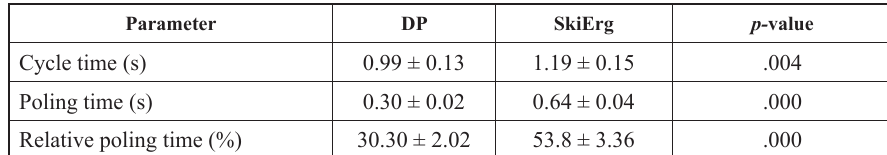
Table 2. Average duration of muscle activity during DP and SkiErg workout (% of average cycle duration)